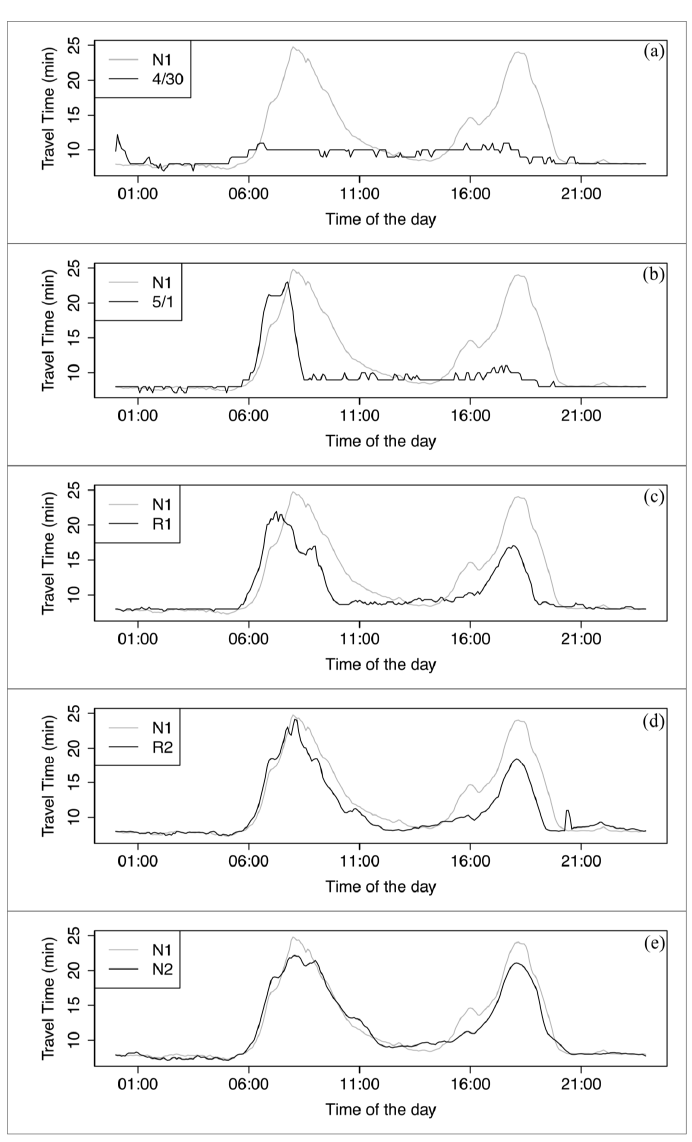
Figure 7. ( a – e ) Travel time distributions of the route from the MacArthur Maze to the end point of the I ‐ 80W depends on the several analysis